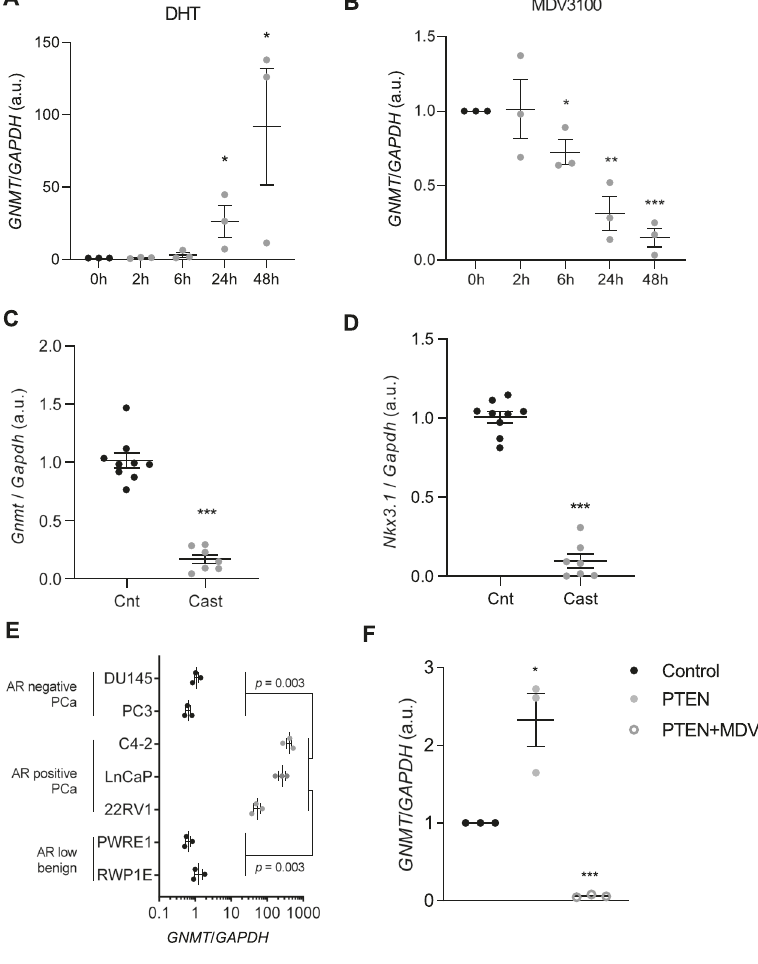
Fig. 2 GNMT regulation by AR. A – B Effect of AR activation with 5 α -dihydrotestosterone (DHT) ( A ) and AR inhibition by MDV3100 ( B ) on GNMT mRNA levels in a time course in LNCaP cells. C – D Effect of surgical castration of 6-month old Pten pc − / − mice on Gnmt ( C ) and Nkx3.1 ( D ) mRNA expression monitored by qPCR ( n = 8 – 10) (Cnt Control non-castrated, Cast Castrated). E GNMT mRNA levels in prostate cancer cell lines with AR activity (represented with grey dots) and with low or no activity (black dots) ( n = 3). F GNMT mRNA expression upon doxycycline-inducible expression (24 h) of YFP-PTEN in PTEN -de fi cient LNCaP prostate cancer cells in the presence or absence of the AR antagonist MDV3100 ( n = 3). Values are represented as mean with SEM. Statistics: One sample T -test ( A , B , F ); Mann – Whitney U -test ( C , D ) and Student T -test with Welch correction ( E ). p , p value; * p < 0.05; ** p < 0.01; *** p <